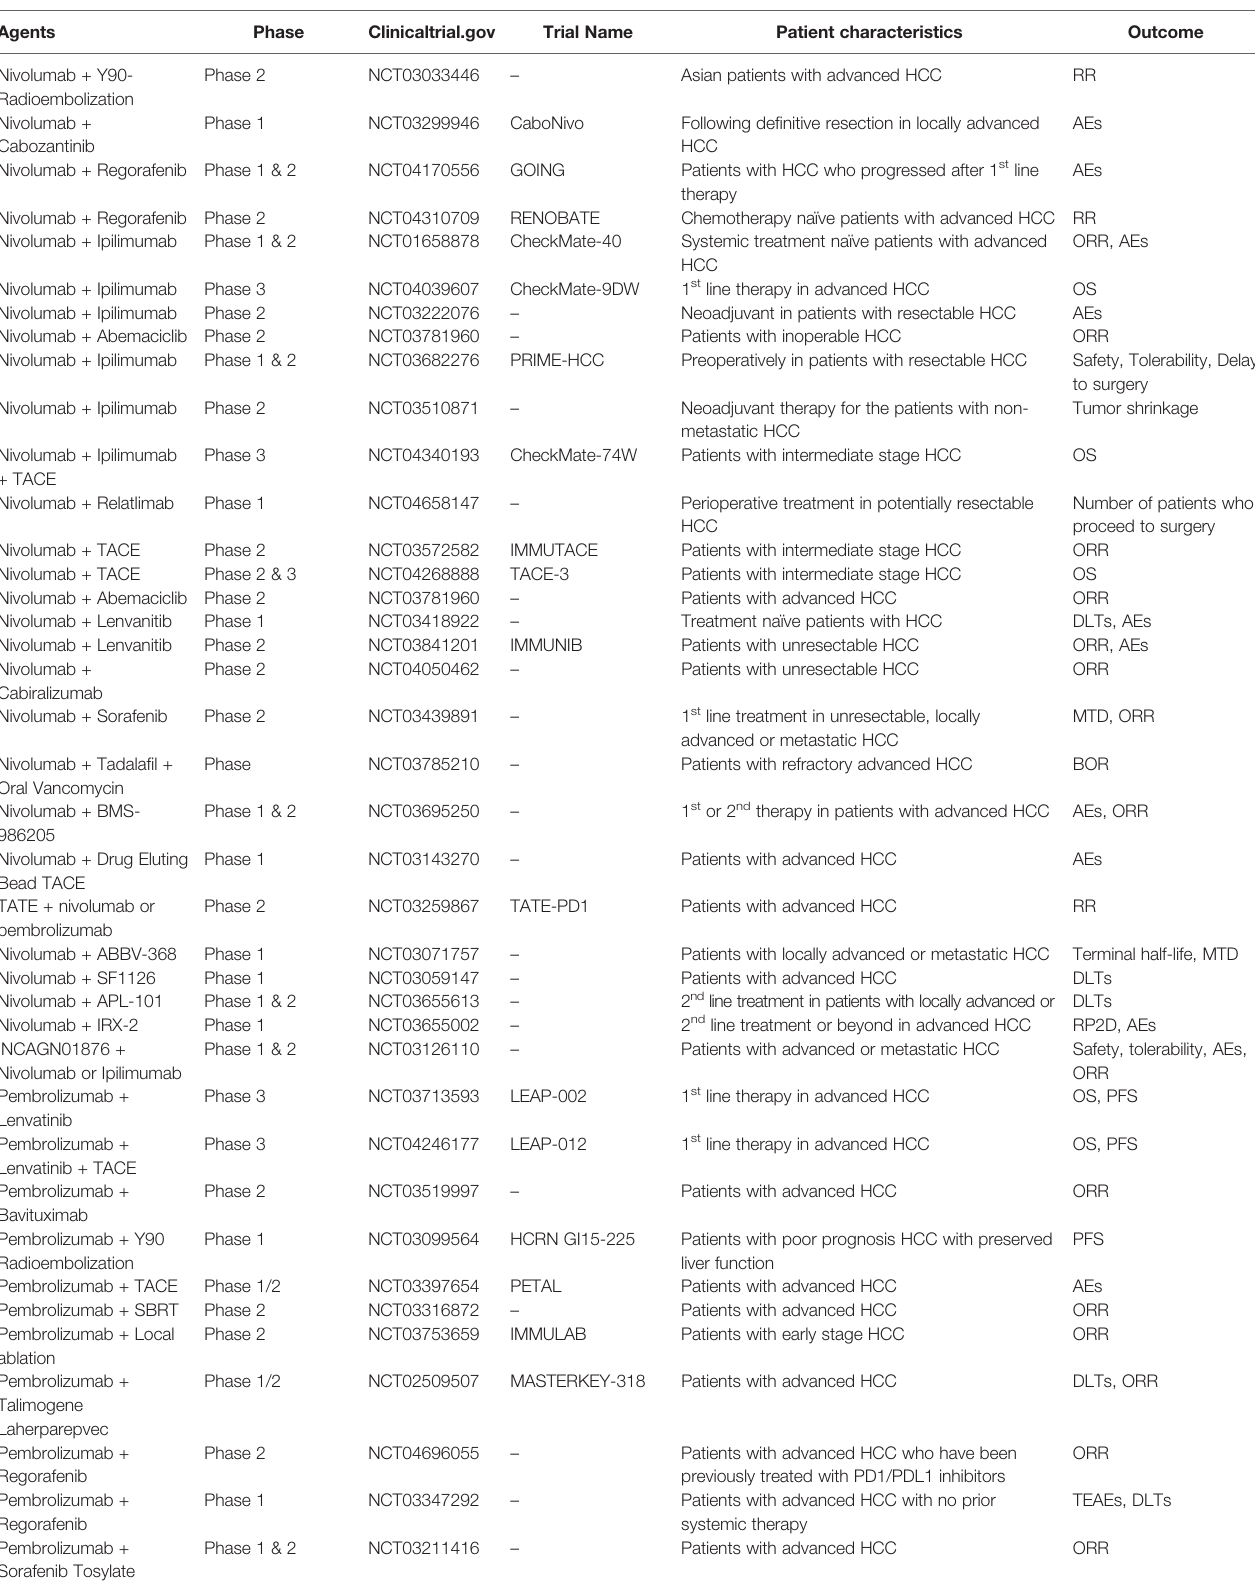
TABLE 2 | Ongoing clinical trials of combination therapy for immune checkpoint inhibitors in hepatocellular carcinoma